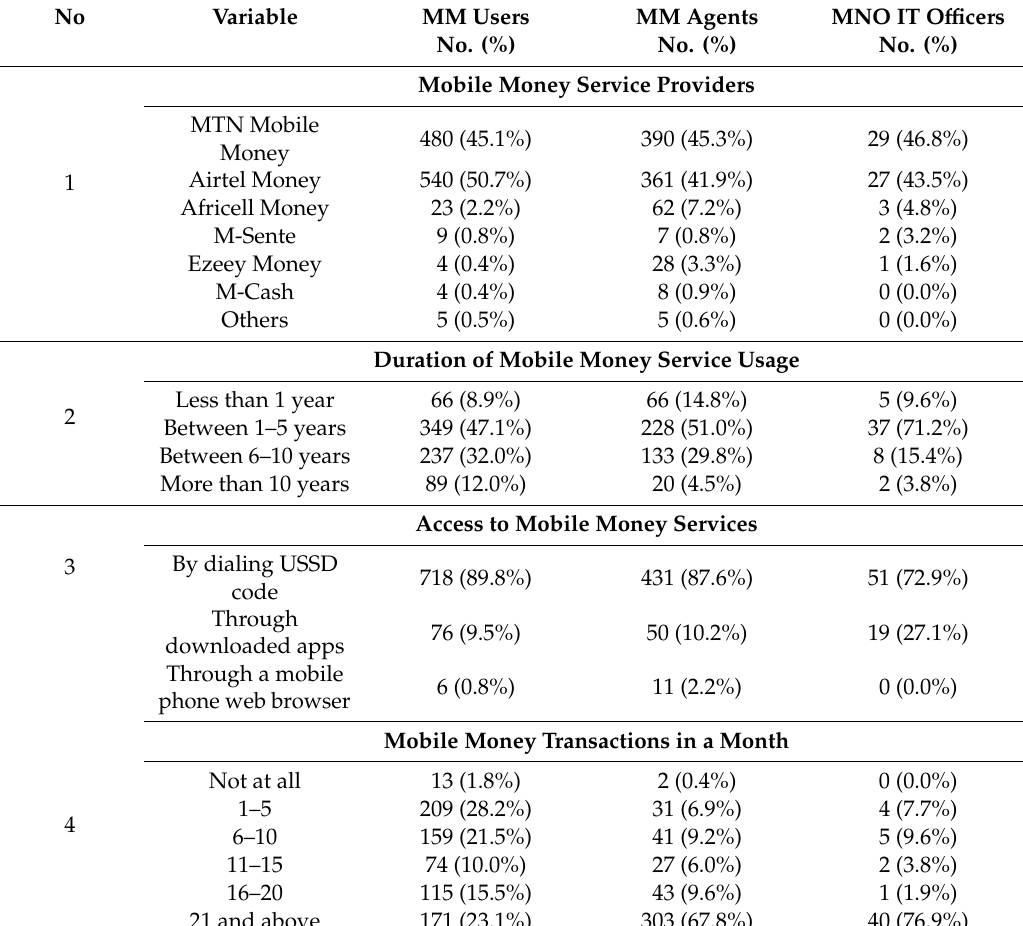
Table 2. Respondents’ mobile money service characteristic, i.e., mobile money service providers, duration of mobile money service usage, access to mobile money services, and mobile money transactions in a